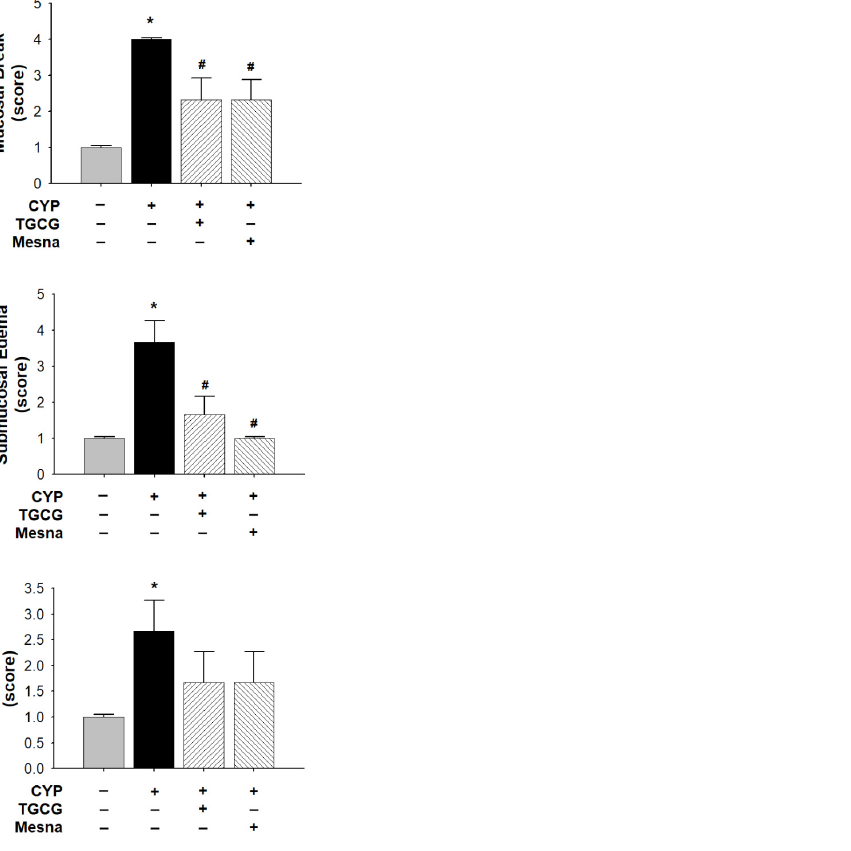
Figure 5. Histological analyses of bladder wall as signified by mucosal break, edema, and hemorrhage between group 1—saline-injected control, group 2—CYP + placebo with normal saline, group 3—CYP + TGCG (200 mg/kg), and group 4—CYP + Mesna (30 mg/kg). Each bar in the figures denotes the mean ± standard deviation. * p < 0.05 compared to control group. # p < 0.05 compared to CYP.